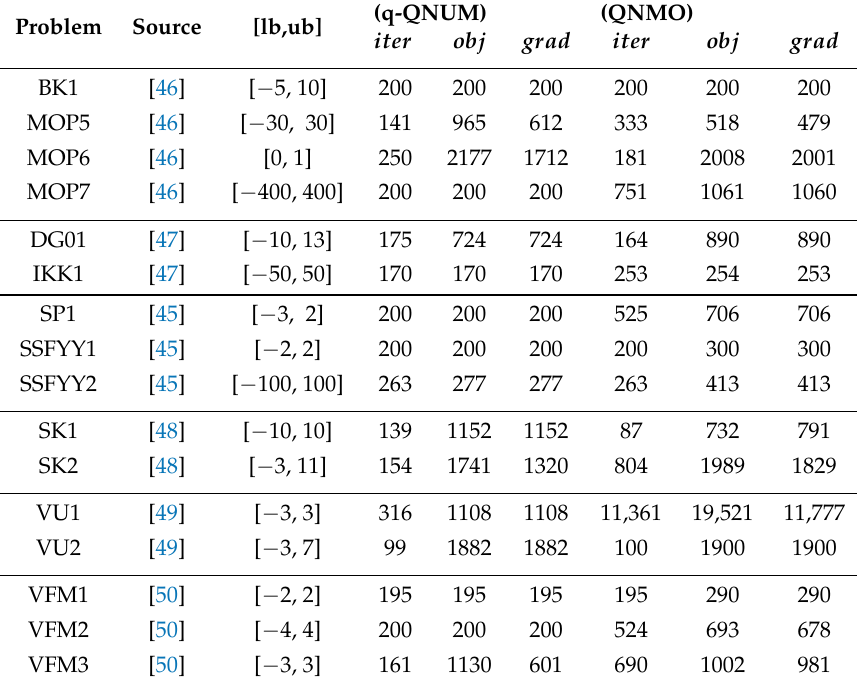
Table 1. Numerical Results of Test